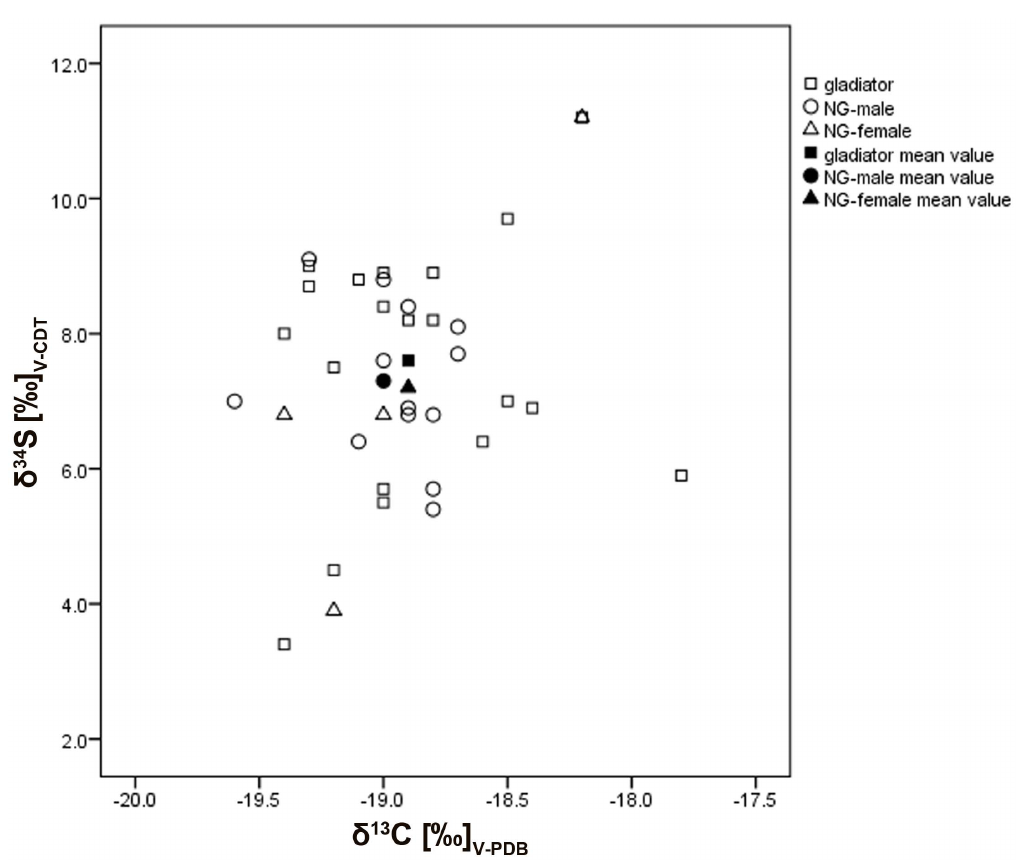
Figure 4. Stable d 13 C and d 34 S ratios. Comparison between different groups (gladiators, NG-males, and NG-females).